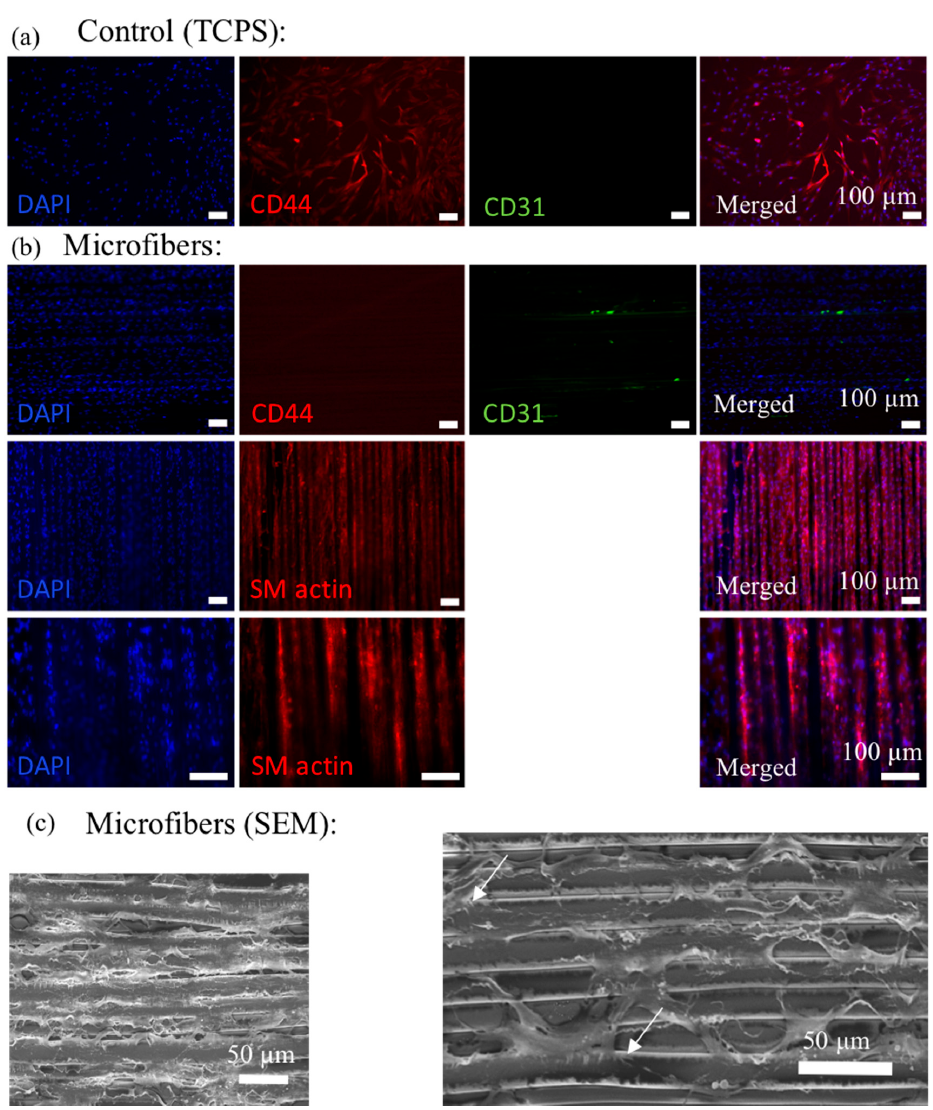
Figure 7. Cy3 labeled CD44 (red; positive marker for hMSCs), AlexaFluor 488 labeled CD31 ( green ; negative marker for hMSCs), DAPI nuclear staining ( blue ) and overlaid fluorescent image of immuno-stained cellular components (merged) for the hMSCs on control (TCPS) ( a ) and microfibers ( b ). Cy3 labeled SM actin ( red ), DAPI nuclear staining ( blue ) and overlaid fluorescent image of immuno-stained cellular components (merged) for the hMSCs on microfibers are shown in ( b ); ( c ) SEM images of the hMSCs on the microfibers show that cells can attach well on the microfibers.